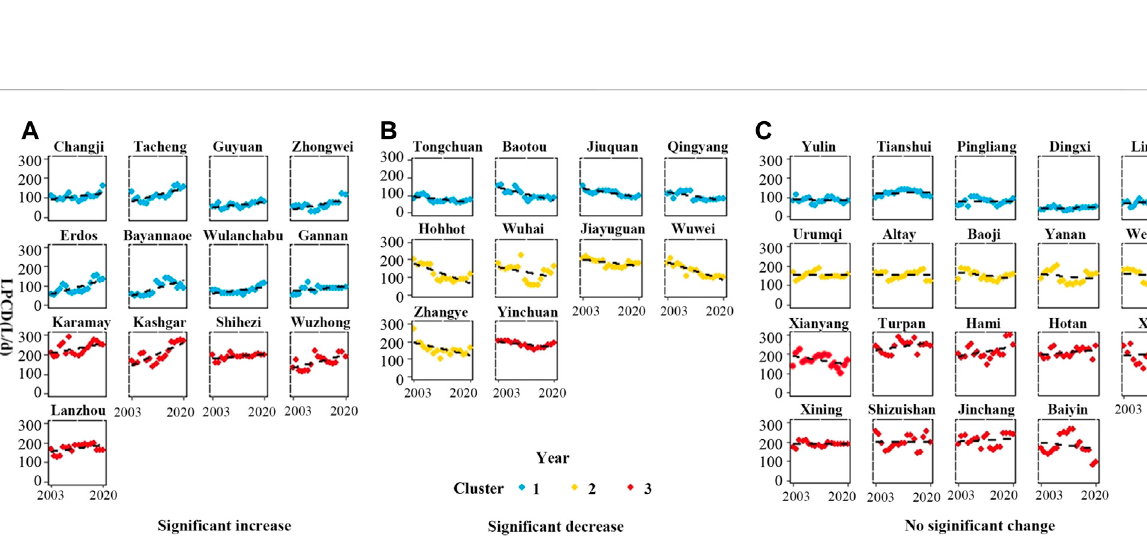
FIGURE 5 Changes of liters per capita per day in the three clusters. Note: (A – C) represents cities with signi fi cant increase, signi fi cant decrease and no signi fi cant change of water consumption from year of 2003 to year of 2020,